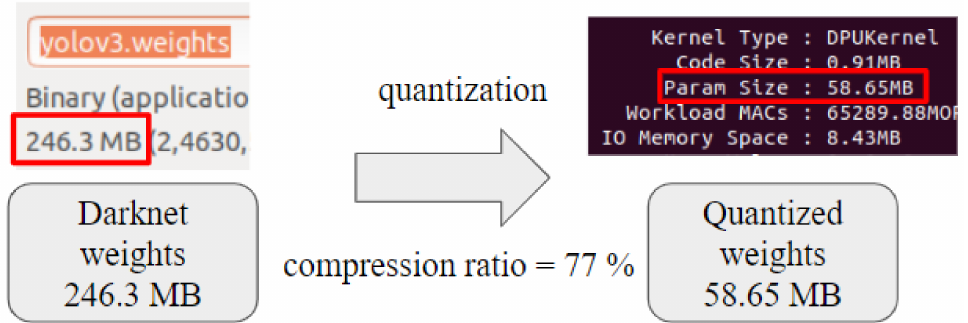
Figure 4. Improvement effect of model compression ratio.